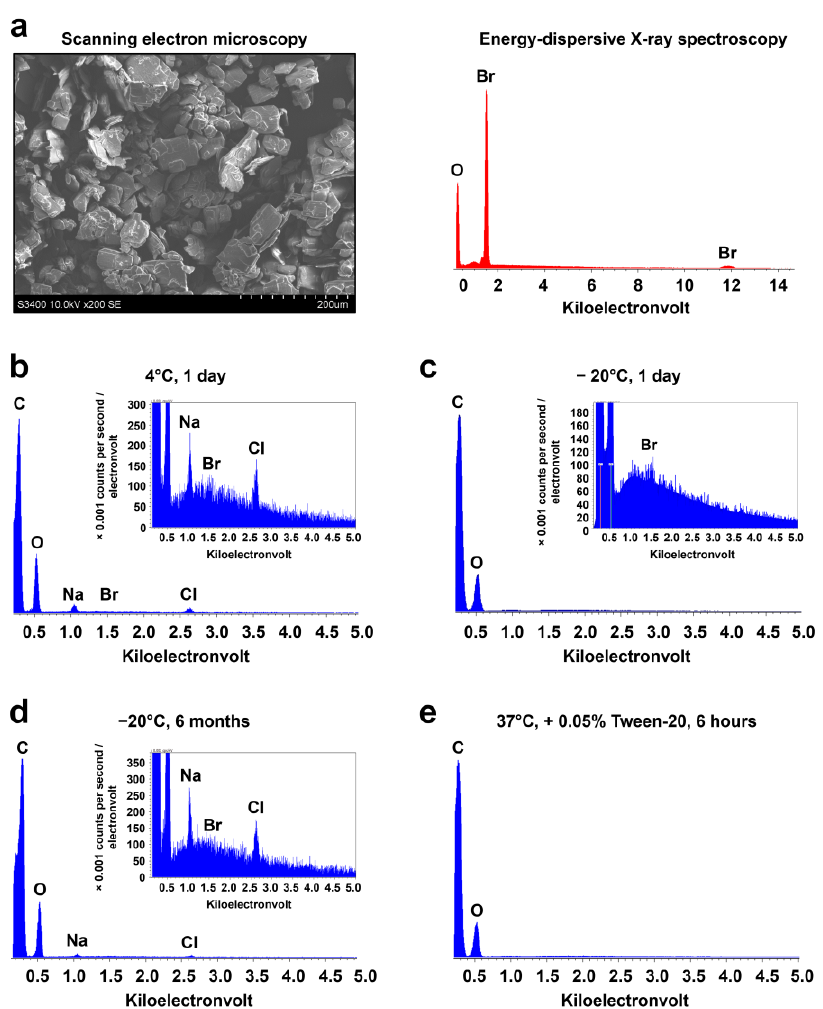
Figure 4. Chemical characterisation of the cationic amphiphilic drug 1,5-bis-(4-tetradecyl-1,4- diazoniabicyclo [2.2.2] octan-1-yl) pentane tetrabromide attached to the TEVG. ( a ) Scanning elec- tron microscopy and energy-dispersive X-ray spectroscopy (EDX) of free 1,5-bis-(4-tetradecyl-1,4- diazoniabicyclo [2.2.2] octan-1-yl) pentane tetrabromide; ( b ) EDX spectra of PCL Ilo/CAD TEVGs stored at 4 ◦ C for 24 h; ( c ) EDX spectra of PCL Ilo/CAD TEVGs stored at − 20 ◦ C for 1 day; ( d ) EDX spectra of PCL Ilo/CAD TEVGs stored at − 20 ◦ C for 6 months; ( e ) EDX spectra of PCL Ilo/CAD TEVGs incubated in PBS supplied with 0.05% Tween-20 at 37 ◦ C for 6 h. Note the absence of the bromine peak in the latter experimental